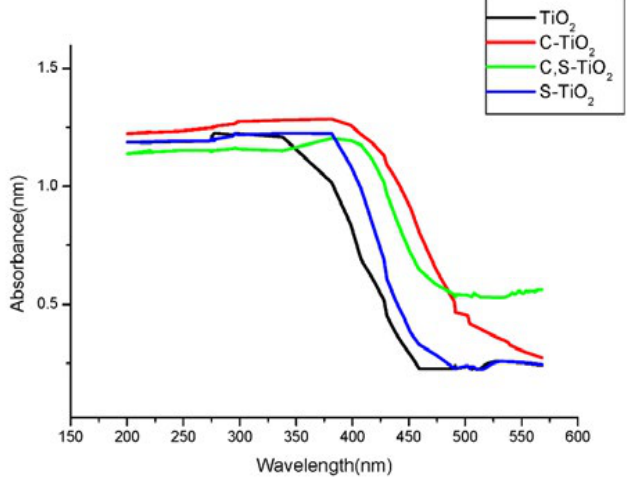
Fig. 3. UV–visible absorption profiles of TiO 2 , C-TiO 2 , S-TiO 2 and C,S-TiO 2 NPs.